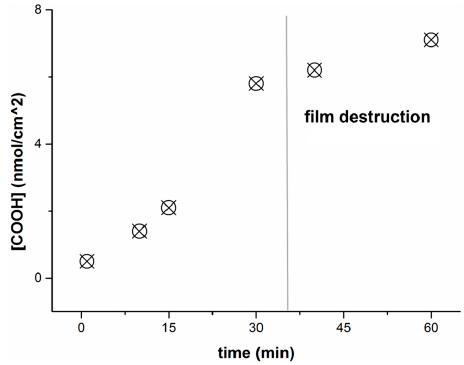
Figure 4. Effect of the time of treatment of the PLA film with 0.1 M NaOH on the surface concentration of generated carboxylic groups.